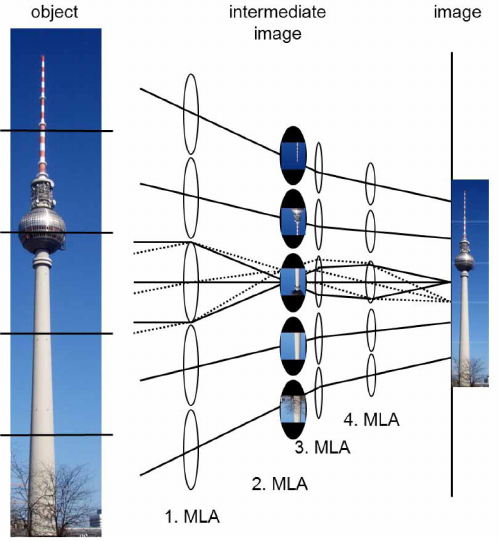
Figure 7. The working principle of the oCley system. Adapted with permission from [39] © The Optical Society.